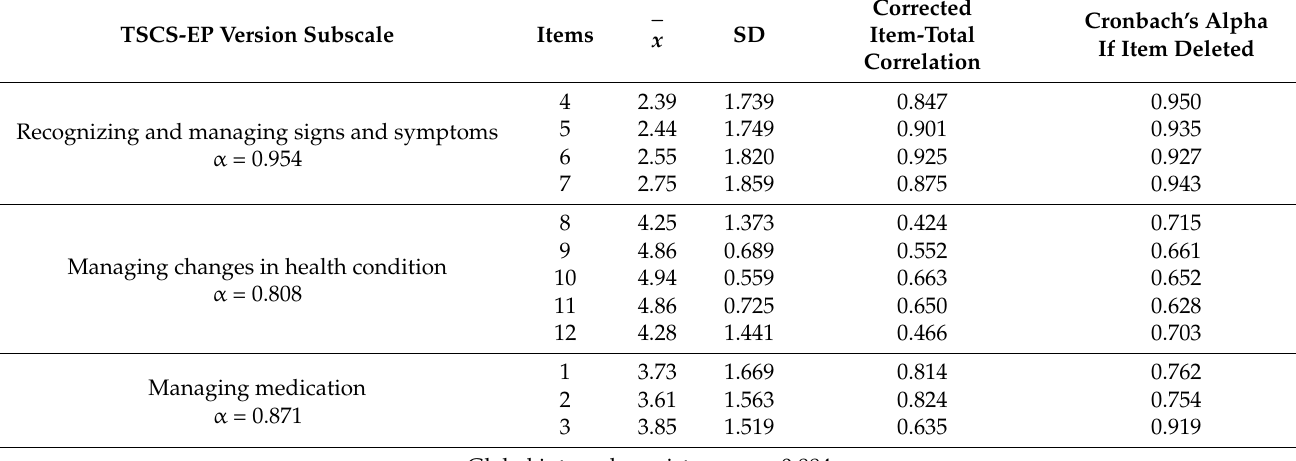
Table 3. Therapeutic Self-Care Scale European Portuguese version dimension